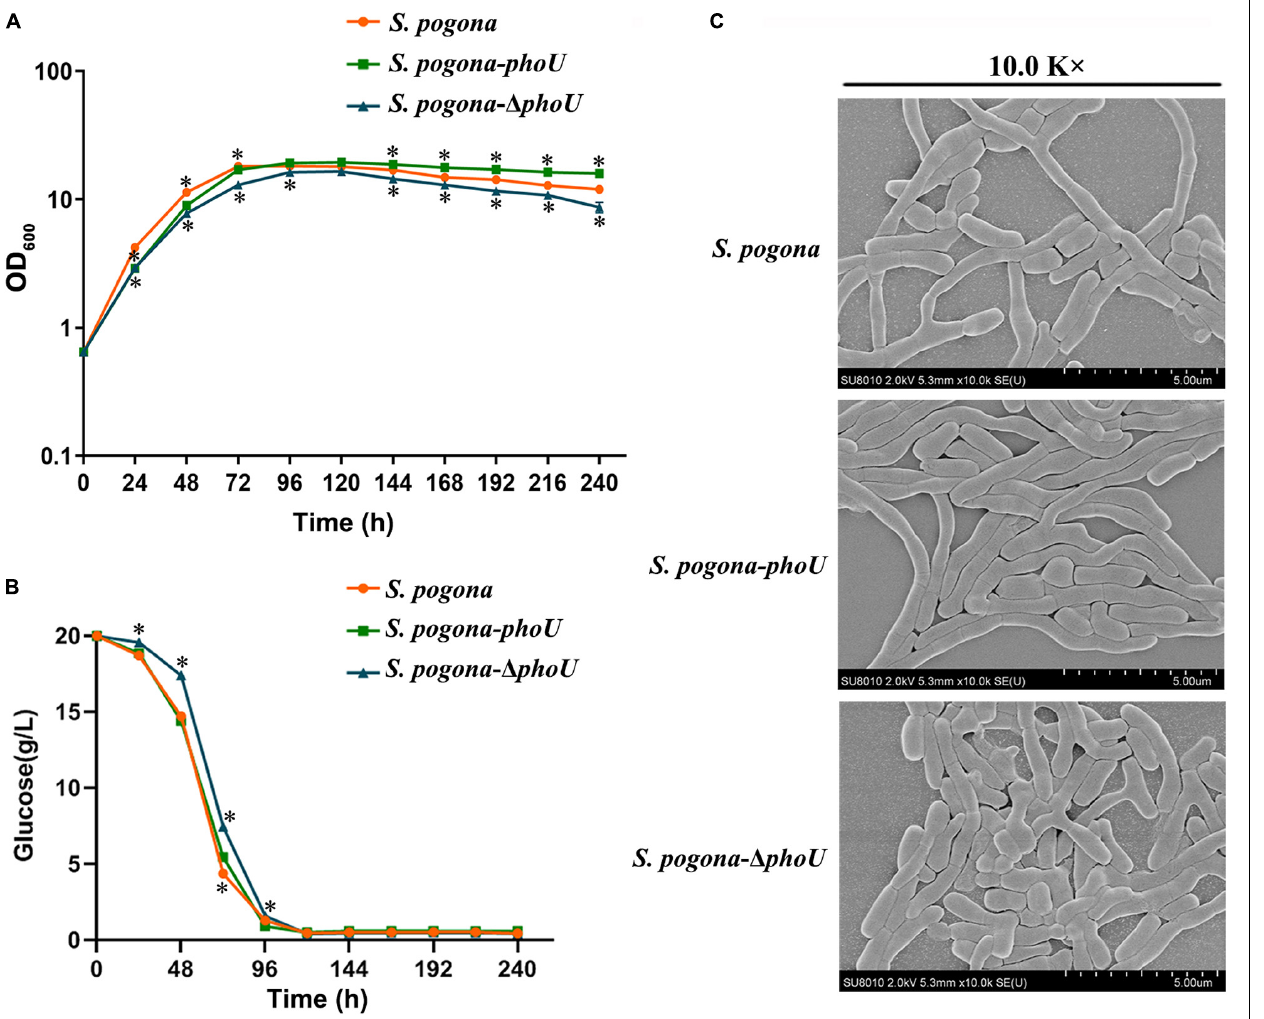
FIGURE 4 | Growth and morphology differences in the wild-type, Saccharopolyspora pogona - (cid:49) phoU and S. pogona - phoU . (A) Growth curves of the recombinant and wild-type strains. These growth curves are plotted using semi-log scales (linear scale for X -axis and log scale for Y -axis). The error bars indicate the standard deviations of three biological replicates. * Indicates P < 0.05, compared to S. pogona under the same conditions. (B) Glucose consumption of the recombinant and wild-type strains. The error bars indicate the standard deviations of three biological replicates. * indicates P < 0.05, compared to S. pogona under the same conditions. (C) Scanning electron microscopy observation of wild-type and engineered